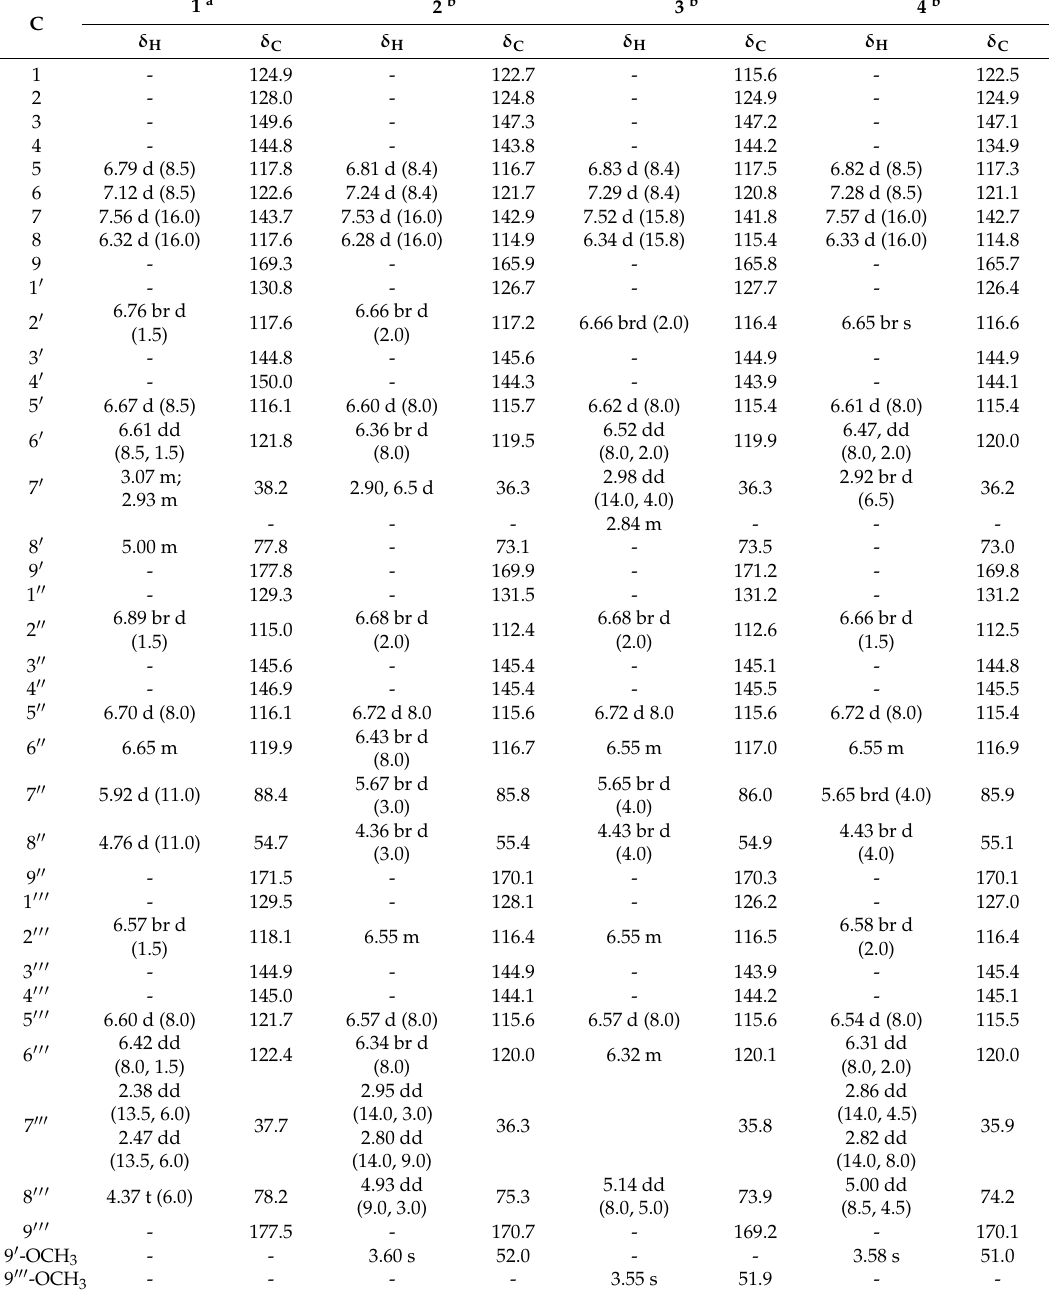
Table 1. 1 H-(500 MHz) and 13 C-NMR (125 MHz) data for the compounds 1 – 4 ( a is recorded in CD 3 OD; b is recorded in DMSO- d 6